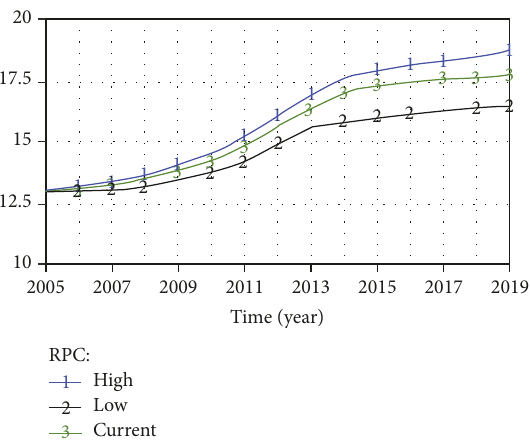
Figure 16: Influences of various trusts on amount of relational psychological contract implemented